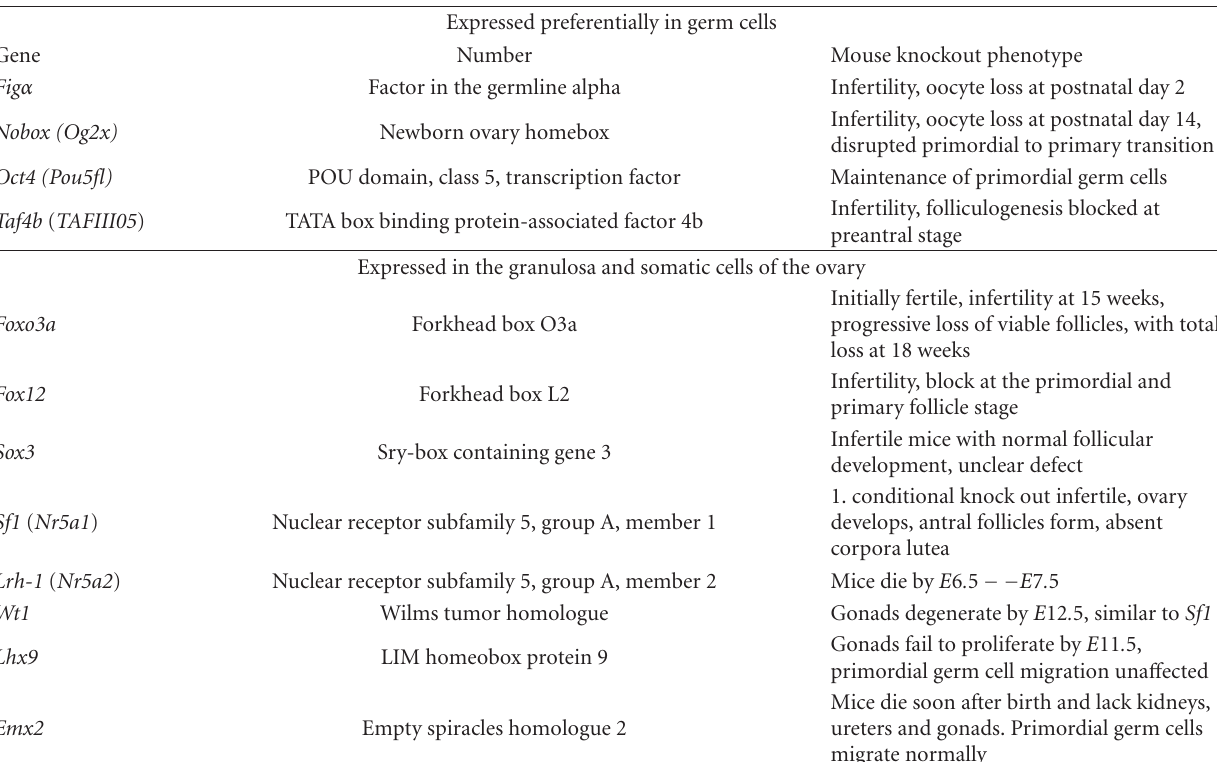
Table 6: Murine model of transcription factors expressed in the gonads and their possible e ff ect on fertility